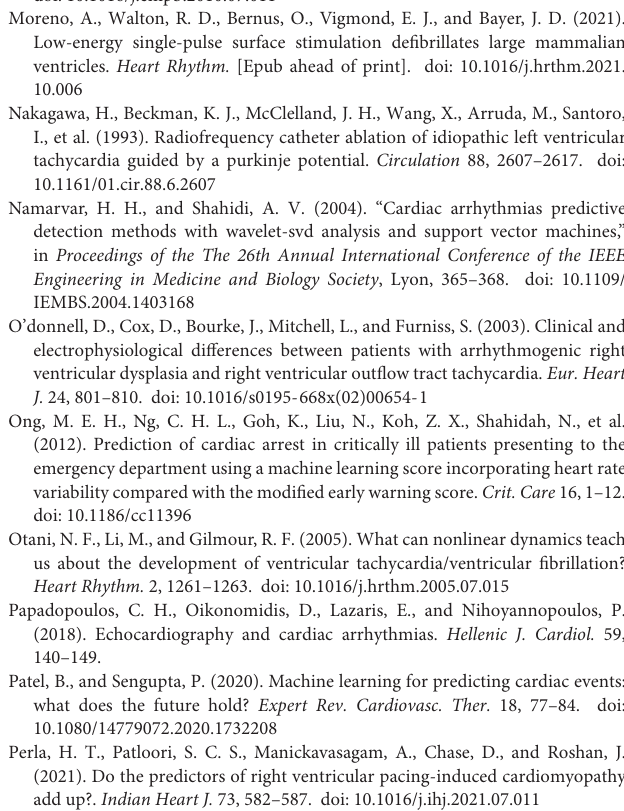
(2021). Do the predictors of right ventricular pacing-induced cardiomyopathy add up?. Indian Heart J. 73, 582–587. doi: 10.1016/j.ihj.2021.07.011